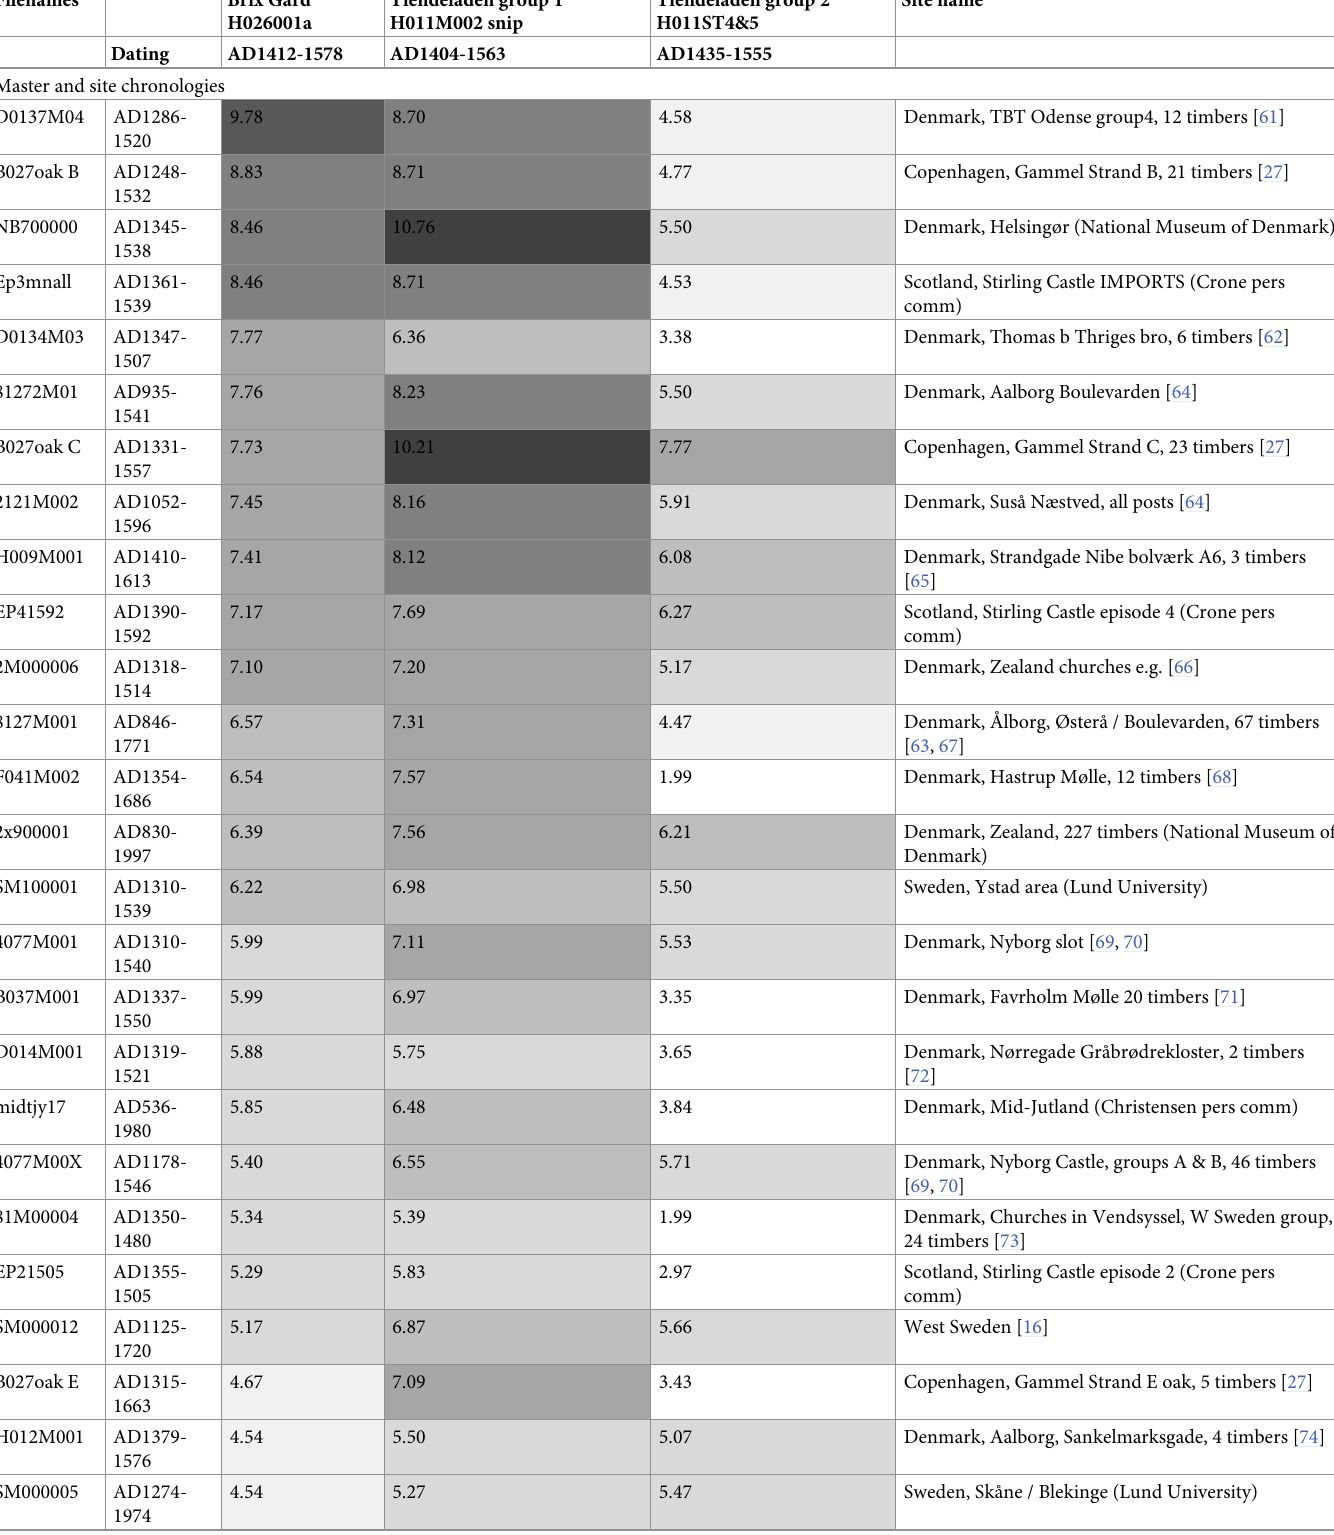
Table 3. Correlation ( t -value Baillie & Pilcher [57]) between the three tree-ring groups from Brix G å rd and Tiendeladen and a range of chronologies for oak. These three groups dendrochronologically indicate a western Swedish